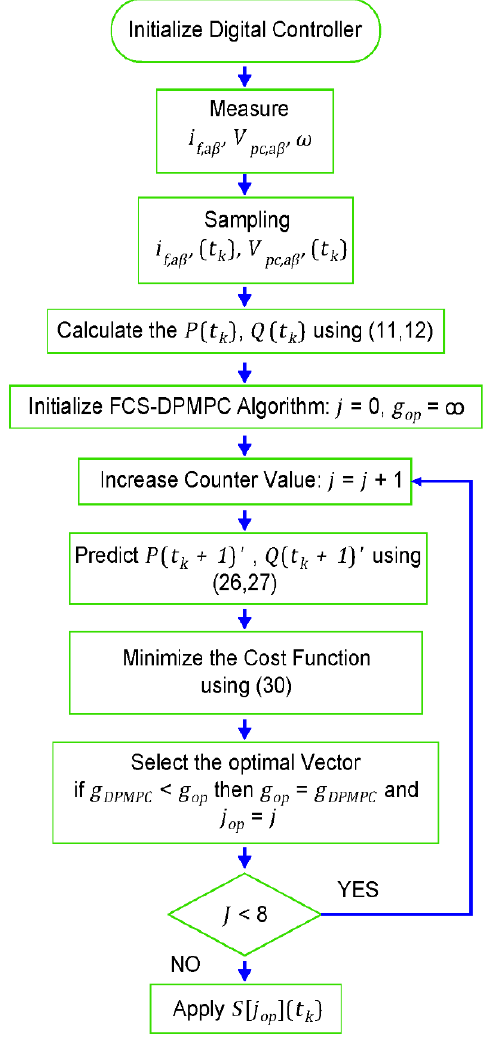
Figure 7. Algorithm for the proposed modified FCS-DPMPC.